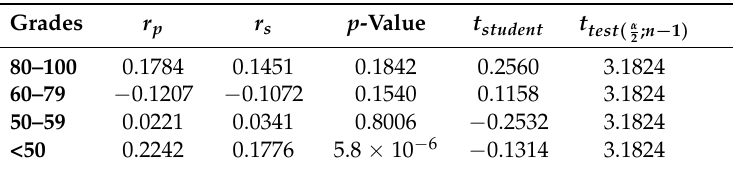
Table 5. Correlation and t student test between the grades obtained by students, and the number of ICT resources used during each